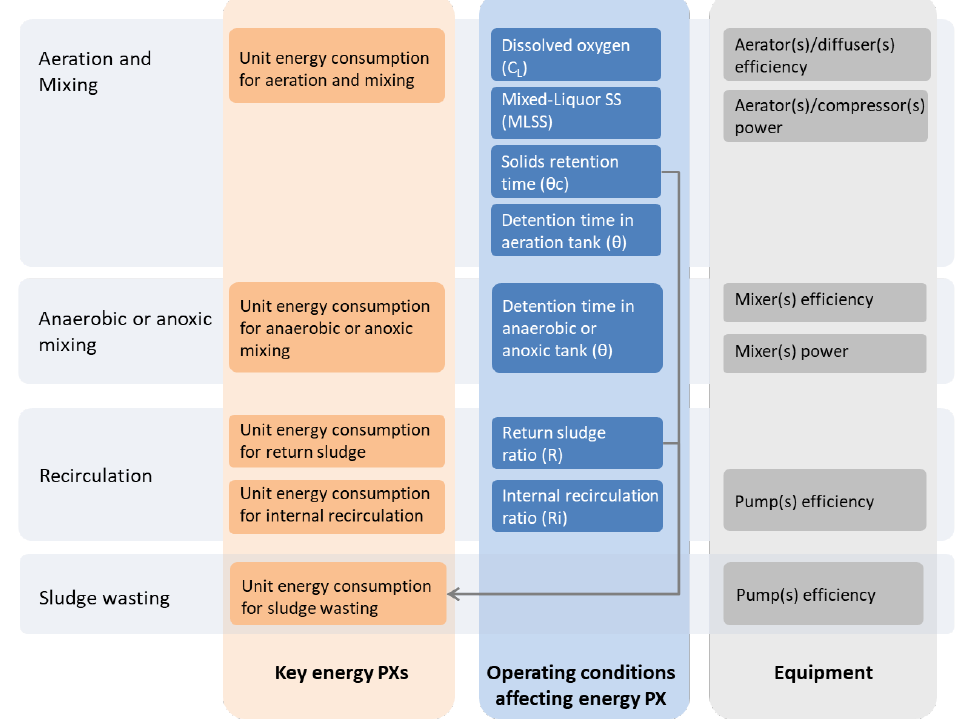
Figure 2. State variables selected for assessing the energy performance of AS systems. Figure 2. The state variables selected for assessing the energy performance of AS systems. In activated sludge systems, energy is consumed for aeration and mixing, recirculation, and sludge